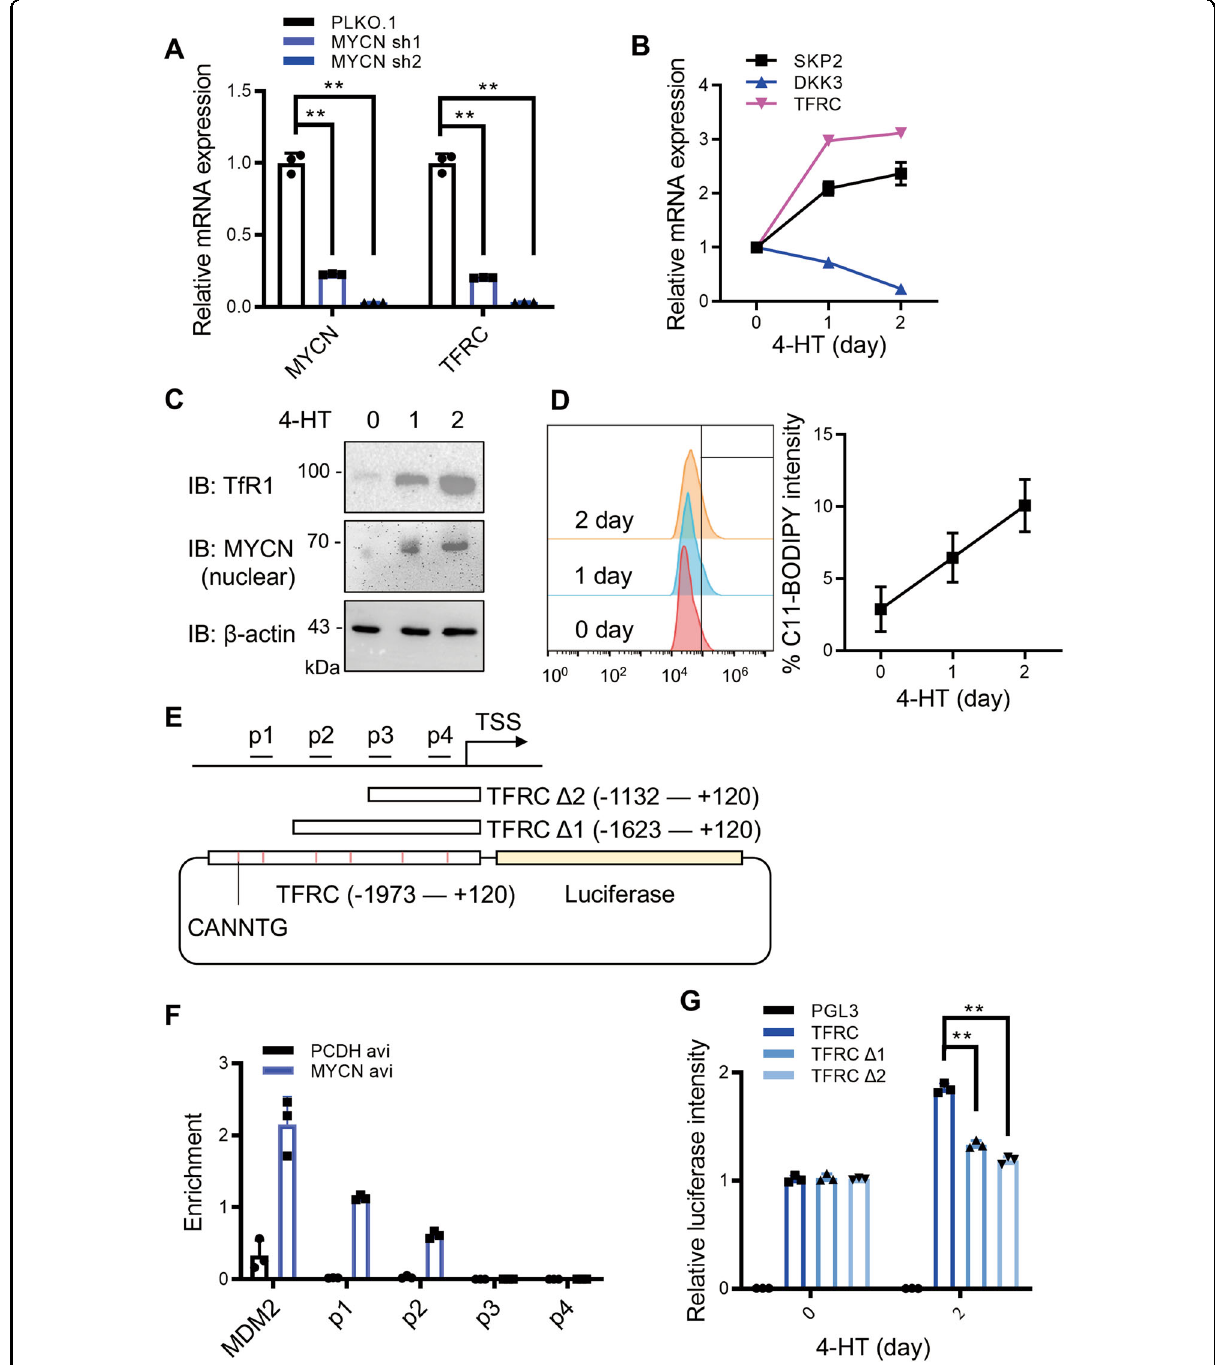
Fig. 6 TFRC is a direct downstream target of MYCN . A RT-qPCR analysis of SK-N-BE2 cells with or without MYCN depletion. MYCN activation induced by 4-hydroxytamoxifen (4-HT) treatment promotes TFRC expression at both mRNA B and protein C levels. SKP2, DKK3 were used as positive and negative controls, respectively. D Amounts of cellular lipid peroxides measured by C11-BODIPY upon MYCN activation. E Primers designed for ChIP-qPCR analysis, and sequence variants for luciferase assays based on the TFRC promoter region. F ChIP-qPCR analysis of different binding sites of MYCN on the TFRC promoter. MDM2 is a positive control for MYCN binding. G Dual-luciferase assays based on ( E ). Signal values were normalized to no 4-HT treatment (day 0). Data are presented as mean ± SD of three replicates. Two-tailed unpaired t -tests were performed to calculate p values. ** p <